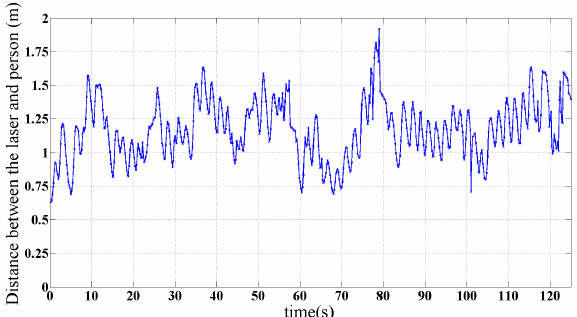
Figure 7: Following distance as a function of time for one of the person following